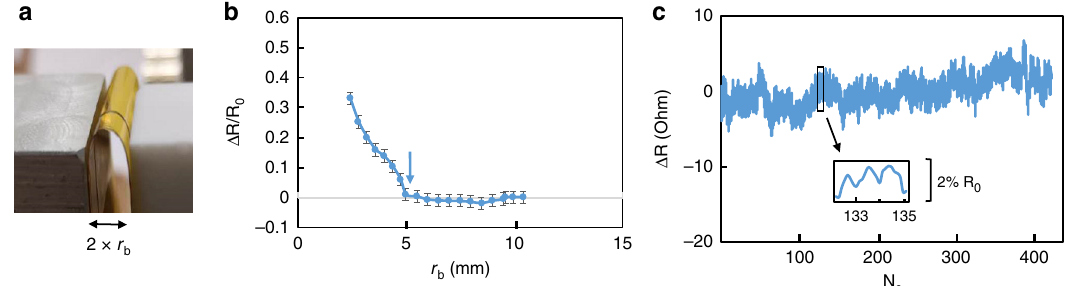
Fig. 4 Bending studies of the thermoelectric threads. a The picture indicates a bending radius r b = 5 mm of p -type thread held over a fl exible Kapton plastic support. b The normalized electrical resistance change of a representative p -type thread was zero for bending radii larger than r b = 5 mm and increased by 30% upon reducing to r b = 2 mm. c The resistance shows no long term degradation even after hundreds of fl exing cycles, indexed by N c .